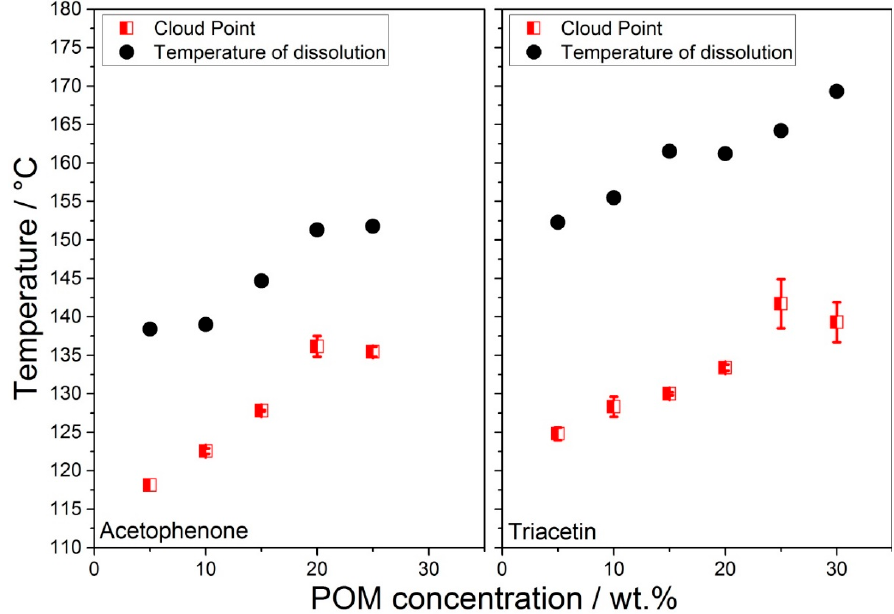
Figure 3. Cloud points of POM in acetophenone (left) and triacetin (right) for POM concentrations up to 30 wt.%. For the acetophenone system, investigation of the cloud point at 30 wt.% could not be achieved, due to incomplete dissolution.